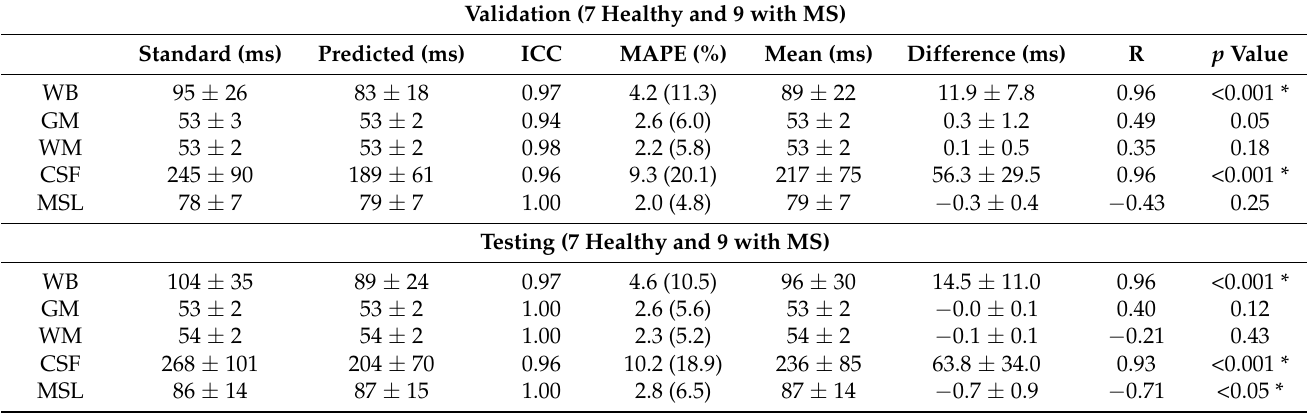
Table 3. Statistical analysis of T2* relaxation times between dictionary matching and the proposed two-stage model for each tissue of scanned